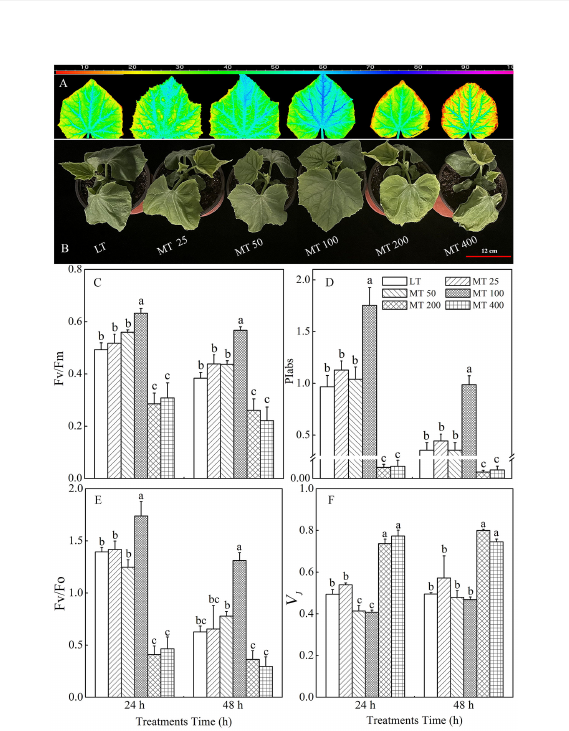
FIGURE 1 The image of Fv/Fm (A) , phenotype (B) , and the value of Fv/Fm (C) , PIabs (D) , Fv/Fo (E) , and V J (F) of cucumber seedlings as affected by different melatonin (MT) levels under low temperature stress. The values were represented by the means ± SE of three replicates. The same letters denoted that there are no signi fi cant differences at P < 0.05 according to Duncan ’ s